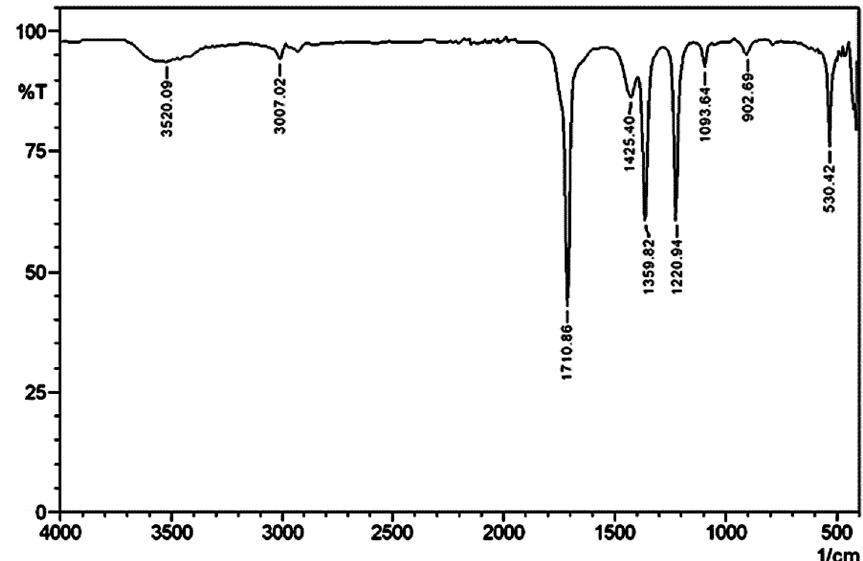
Fig. 7 FTIR analysis of lipid from treated microalga Chlo- rella